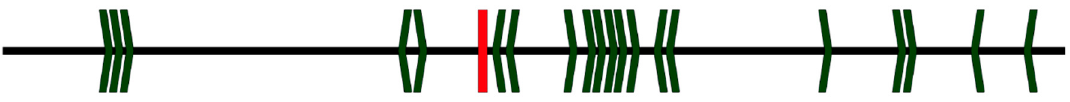
Figure 3. Schematic localization of the candidate Rf1 genes within the 7.72 Mb region. Green arrows indicate the gene sequences of the PPR family. The direction of the arrow reflects the orientation of the sequence in the genome. Red box indicates the location of the Probable aldehyde dehydrogenase 5F1gene.